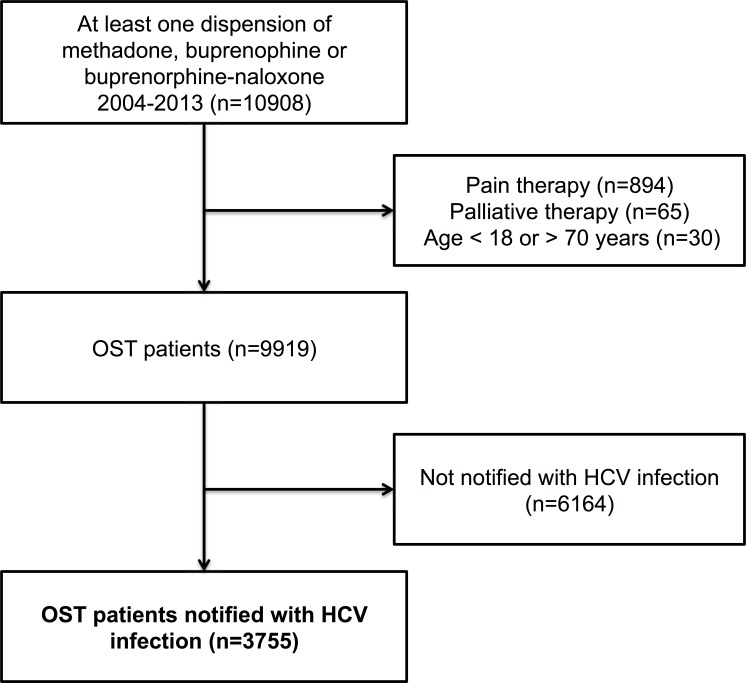
Study population (n = 3755).